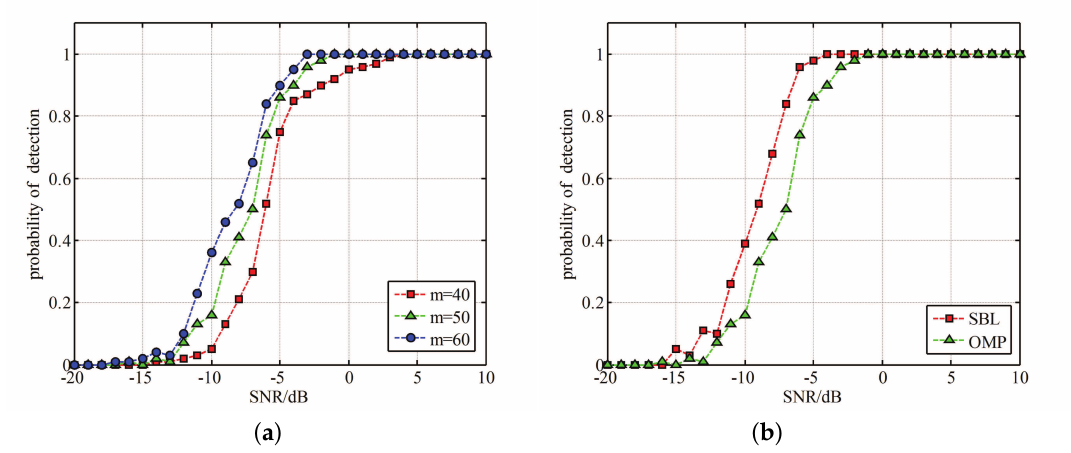
Figure 13. Two simulation results of the hardware prototype. ( a ) Detection performance with different m and SNR; ( b ) Detection performance comparison between SBL and OMP.